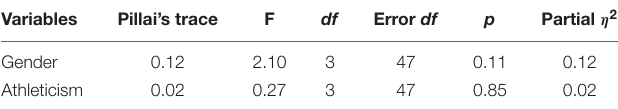
TABLE 3 | Multivariate tests for gender and athleticism on HF-HRV.